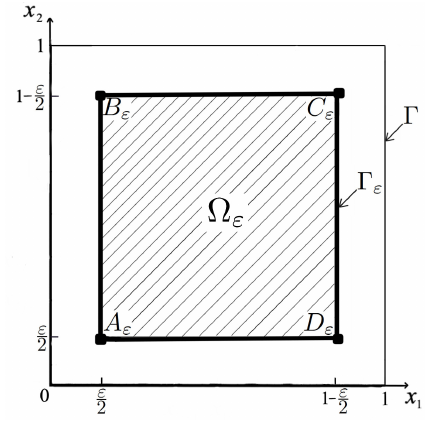
Figure 1. The sets Ω ε , Γ ε and γ ε .